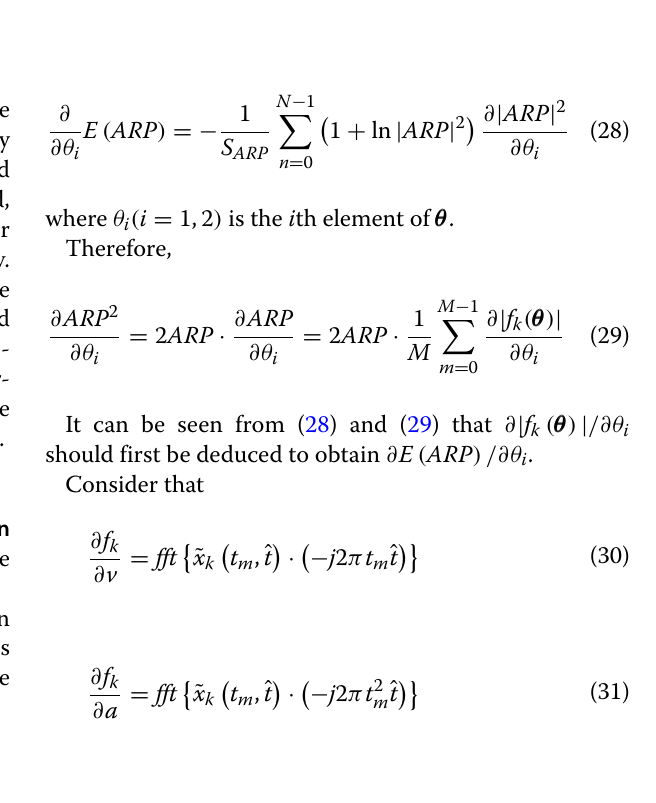
Fig. 14 Estimation results under a − 20 dB SNR. a The estimation result of the proposed algorithm, b the estimation result of the ACM, and c the estimation result of the